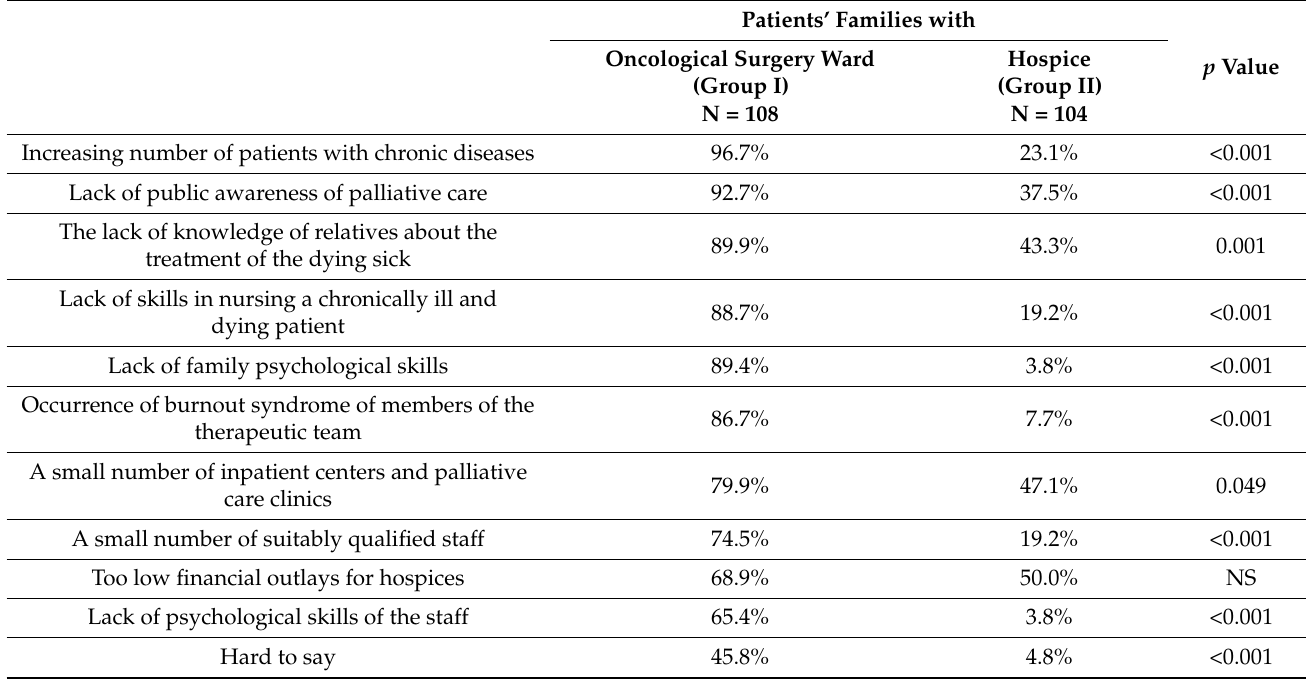
Table 13. Opinions on problems in patient care at the end of life *. Patients’ Families